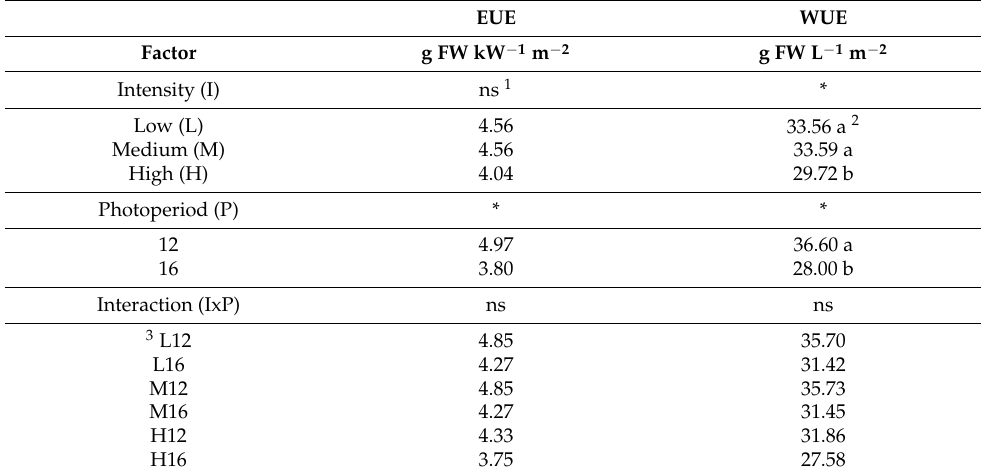
Table 5. Energy (EUE) and water use (WUE) efficiency of beet microgreens under different light treatments. Values are the mean of 3